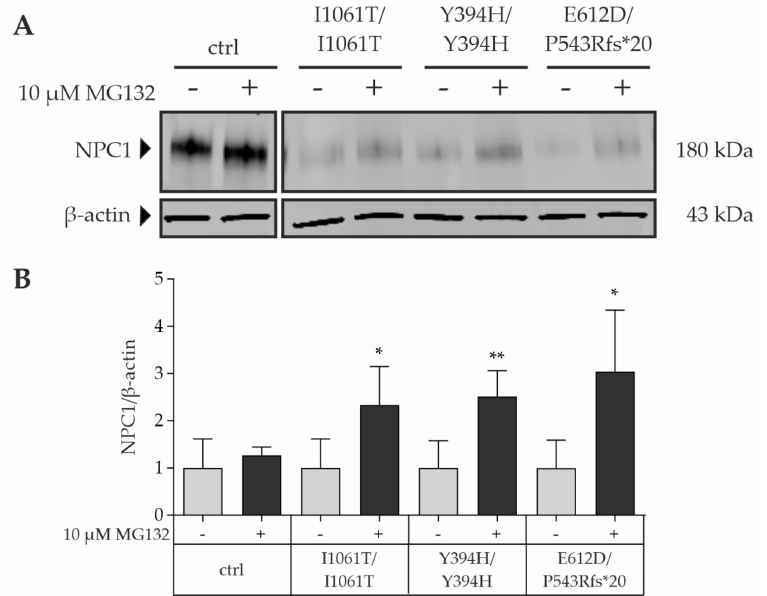
Figure 4. Proteasome inhibitor MG132 leads to an increase of total NPC1 mutant protein. ( A ) Representative Western blot analysis of NPC1 protein level in normal and NPC1-deficient fibroblasts after treatment with 10 µ M MG132 for 24 h. β -actin was used as a reference protein. ( B ) Determination of the NPC1 band signals revealed a significant increase of mutant NPC1 protein upon treatment with 10 µ M MG132 for 24 h, while the wild-type NPC1 protein did not change. This indicates that the mutant proteins are subjected to proteasomal degradation. N = 4; * = p < 0.05, ** = p < 0.01 by unpaired Student’s t -test compared to untreated